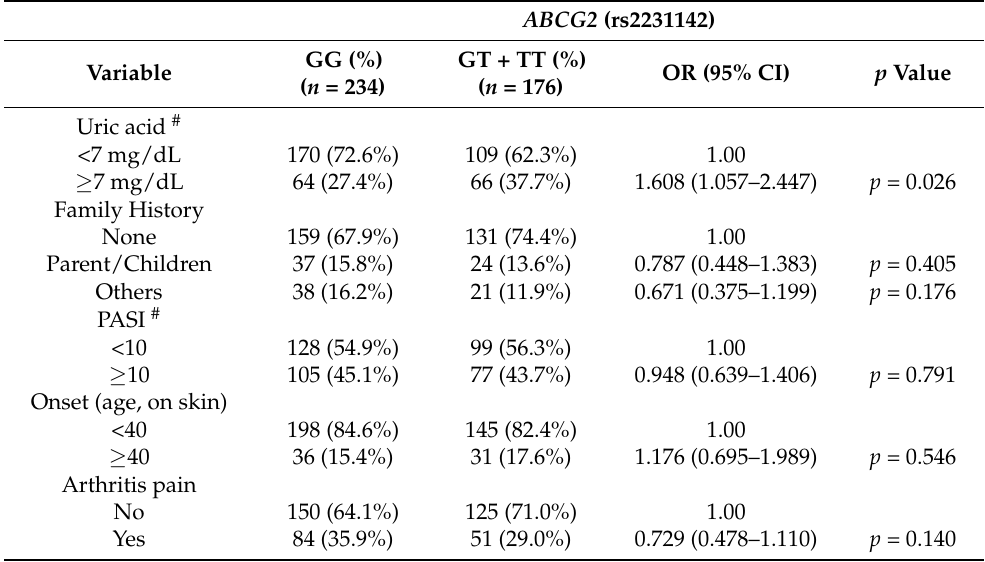
Table 3. Distribution of ABCG2 rs2231142 genotype frequencies and the clinical status among 410 patients with